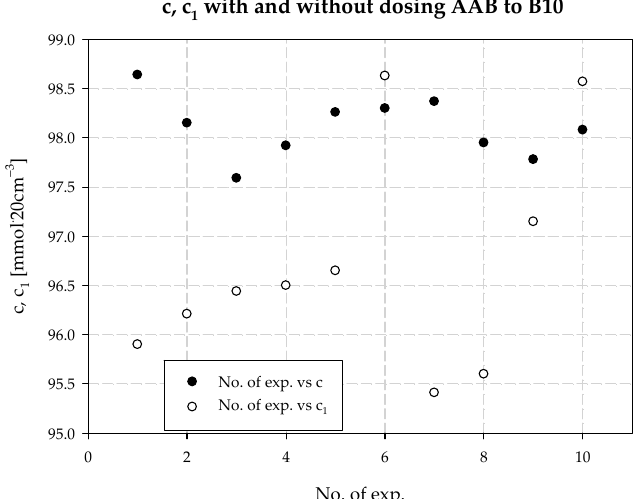
No. of exp. No. of exp. Figure 10. c with and without dosing of AAB to B10. Figure 10. c with and without dosing of AAB to B10. Figure 10. c with and without dosing of AAB to B10. Figure 10. c with and without dosing of AAB to B10.